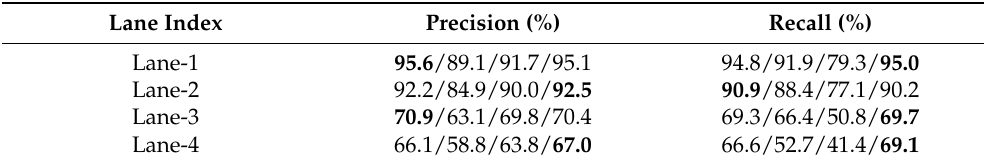
Table 8. Classification Result of different versions of